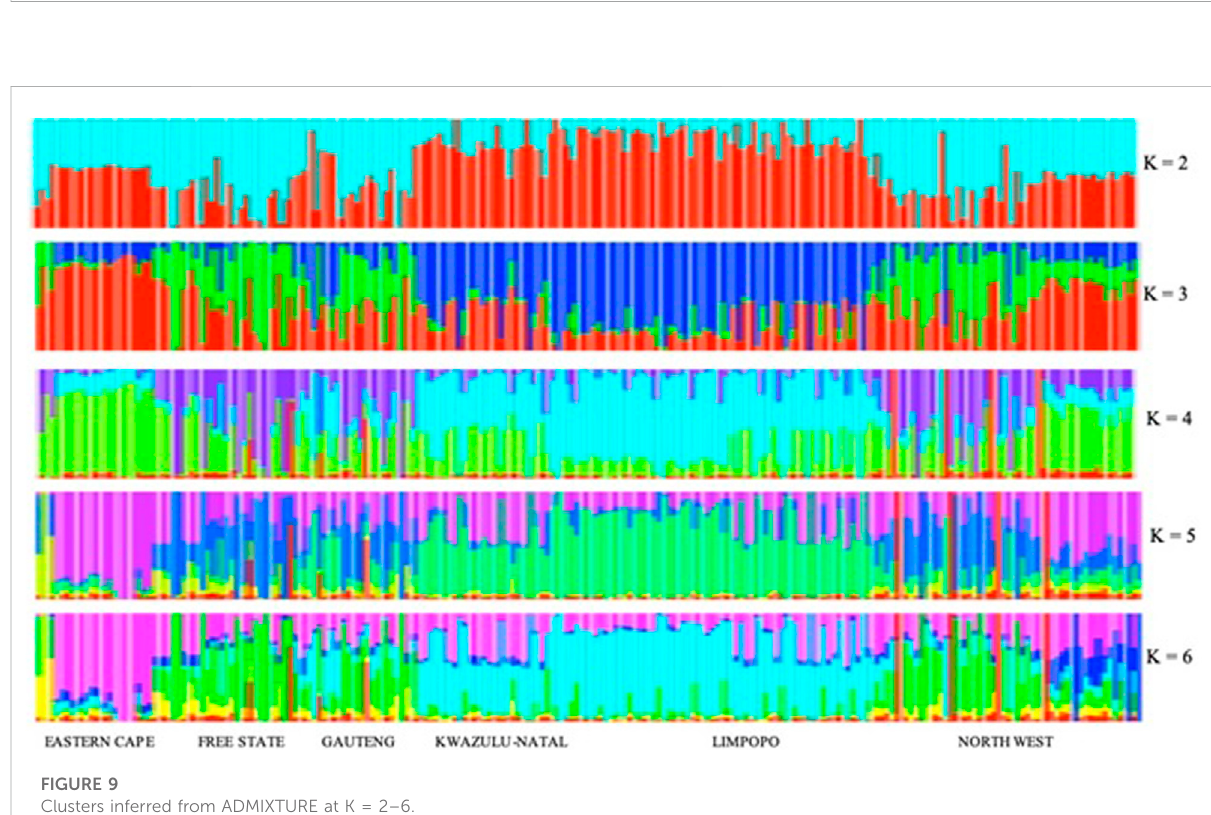
FIGURE 9 Clusters inferred from ADMIXTURE at K = 2 –